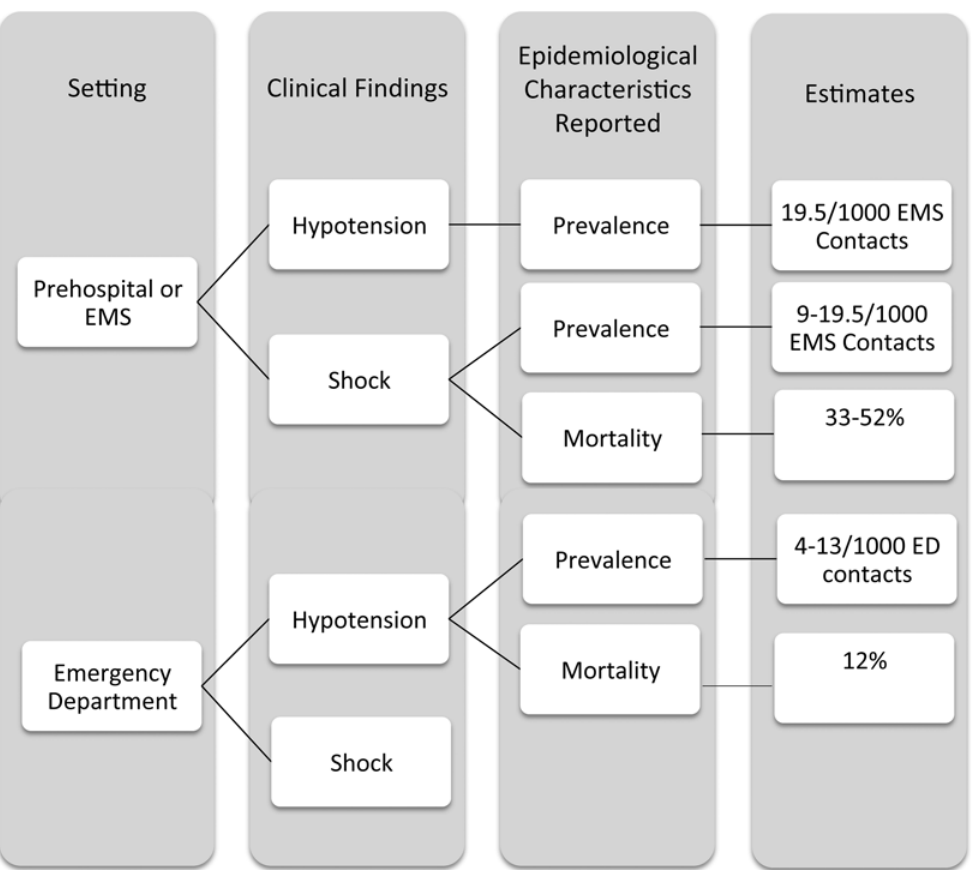
Fig 3. Visual overview of the clinical epidemiological characteristics reported based on setting and clinical